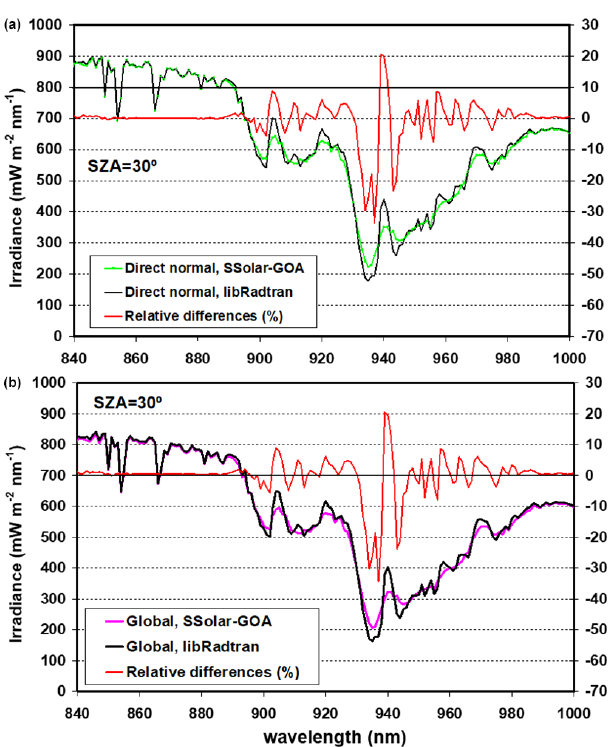
Figure 4. Comparison between libRadtran and SSolar-GOA models in the region of the 940nm absorption band of water vapour for direct normal (a) and global (b) solar irradiances at SZA = 30 ◦ .